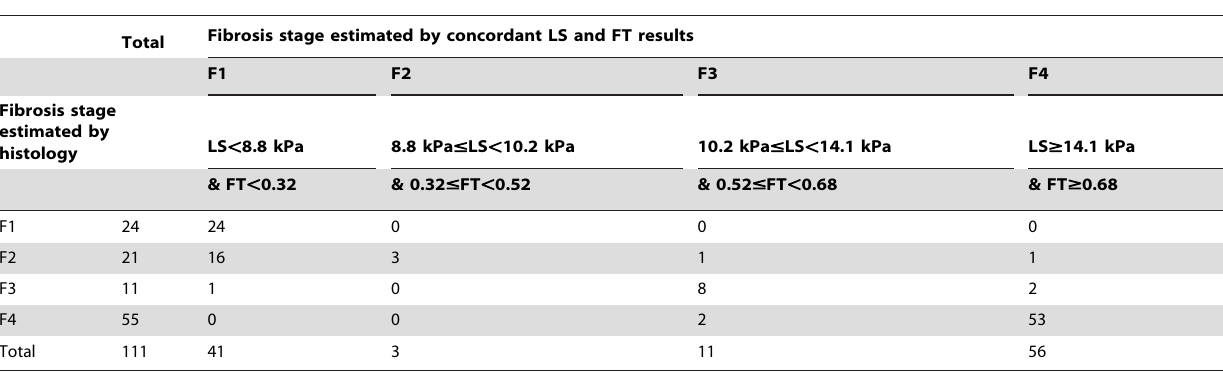
Table 4. Agreements of histological fibrosis stages among patients who showed concordant results between LS and FT (n=111).